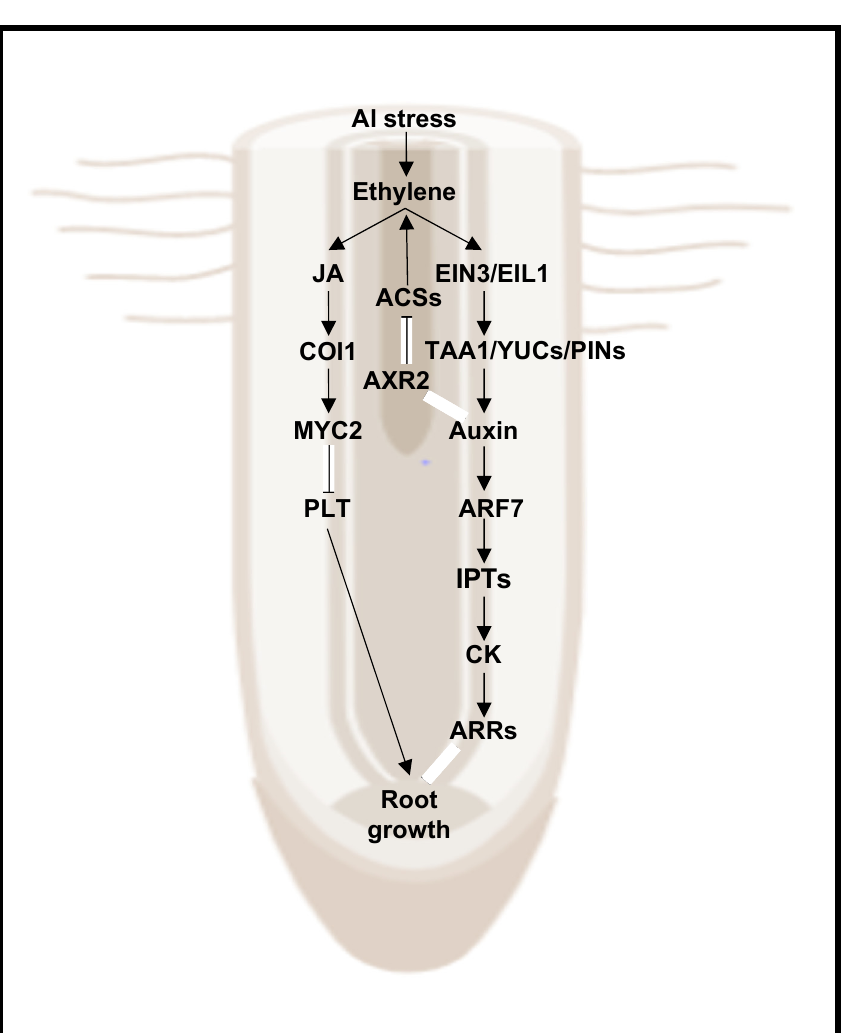
Figure 5. A model of root growth regulation in Arabidopsis triggered by Al stress and mediated by the crosstalk between JA, CK, auxin, and ethylene. Under Al stress, enhanced ethylene production upregulates the local transcript levels of auxin biosynthesis genes TAA1 and YUC s promoted by the transcriptional upregulation of EIN3 and EIL1 . The increased protein abundance of TAA1 and YUCs results in local auxin accumulation within the roots, suppressing primary root growth. Downstream of auxin, local accumulation of CK triggered by ARF7-mediated induction of the CK biosynthesis genes IPT s activates the CK response, which also contributes to root growth inhibition in response to Al stress. In parallel, COI1-mediated JA signaling downstream of ethylene is involved in Al stress-induced root growth inhibition through the transcriptional repression of PLT genes encoding AP2 TFs. Positive interactions such as activation, production, and stabilization are represented with lines that end in an arrowhead → . Negative interactions such as inactivation and repression are represented by lines that end in a hammerhead ⊣ . The background image of an Arabidopsis root was created with BioRender.